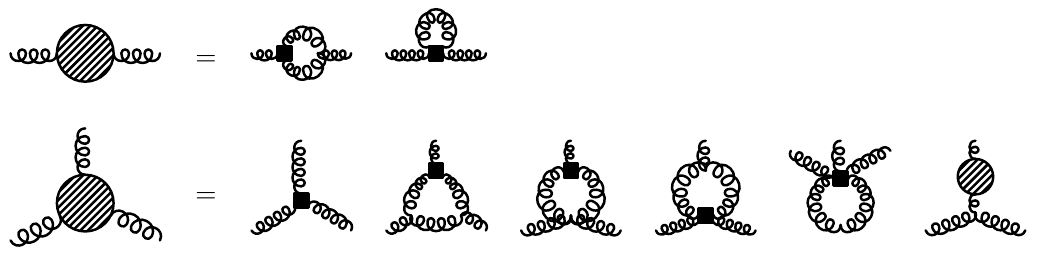
and three-point function (cid:0) (cid:11)(cid:12)(cid:13) ab denoted by a square. Only one possible insertion of the 6